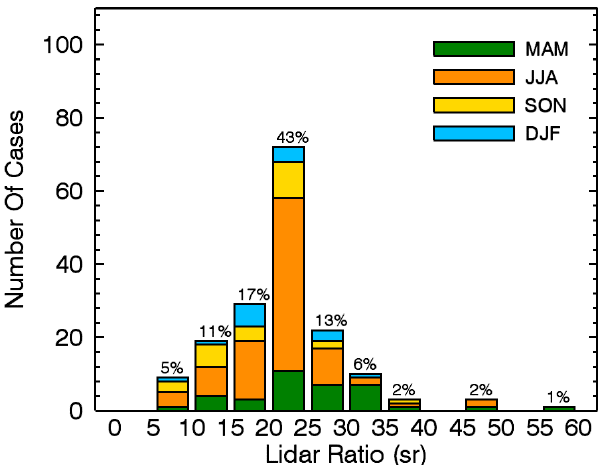
Figure 9. Histogram of the cirrus lidar ratio with seasonal proportion. Note that the cirrus lidar ratio is distributed primarily in the range of 5–40 sr with the most probable values being 20–25 sr. The seasonal mean values of the lidar ratio were 25.4 ± 9.6 (spring), 21.2 ± 6.4 (summer), 18.9 ± 7.0 (autumn), and 20.4 ± 6.0 (winter), respectively. The larger value in spring may be due to the